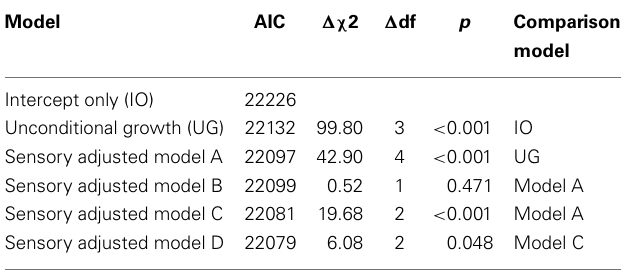
Table 3 | Model fit indices for competing models piecewise linear-mixed models of change in CES-D scores as a function of sensory loss ( n = 1611)